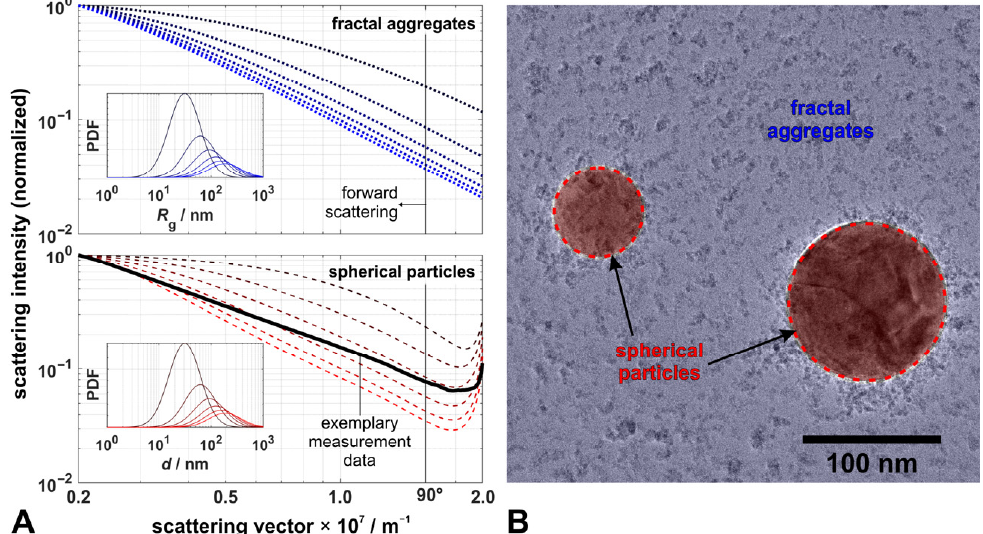
Figure 3. ( A ): Exemplary calculated scattering data for fractal aggregates (blue dotted lines) and spherical particles (red dashed lines) for log-normally distributed sizes (50 nm ≤ µ g ≤ 300 nm, σ g = 2.0) using RDG-FA (with D f = 1.70) and Mie theory (with n = 2.540), respectively (data in double logarithmic scale, 90 ◦ scattering angle visualized). Geometric means µ g refer to R g for fractal aggregates and to d for spheres; the lower diagram includes exemplary experimental scattering data from the EtOH/TTIP-spray flame at 120 mm HAB (black line). ( B ): TEM image showing TiO 2 - particles sampled from the identical spray flame in spherical shape (red areas) and in fractal-like shape (distributed over blue area).